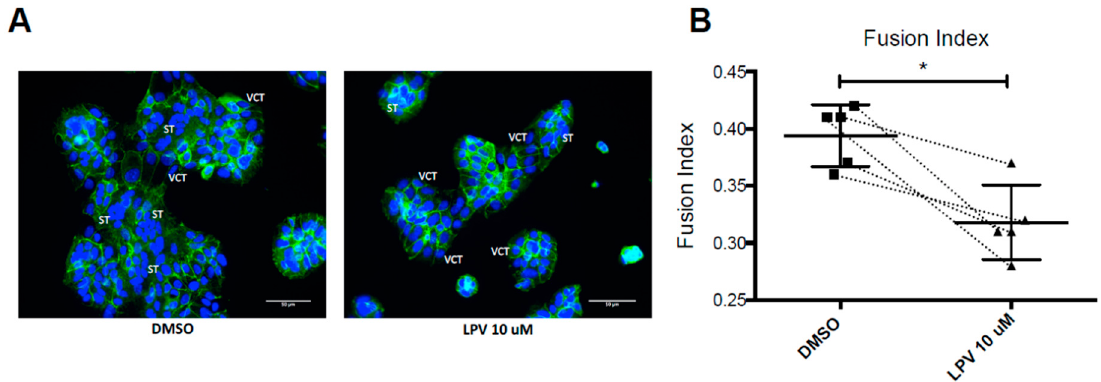
Figure 2. Lopinavir decreases VCTs fusion. VCT isolated and purified from term placenta were cultured for 15 h and then incubated with LPV 10 µM or DMSO for 48 h to allow fusion process. ( A ) Picture of cytotrophoblast fusion process by fixing and immunostaining of cells for the distribution of desmoplakin (green) and nuclei (4 ′ ,6-diamidino-2-phenylindole [DAPI] staining). 400 × magnification. Scale bar: 50 µm. ( B ) Representation of syncytium formation as a fusion index graph. Results are expressed as the mean +/ − SD of n = 5 independent experiments. * p < 0.05 vs. DMSO, Mann-Whitney t -test.